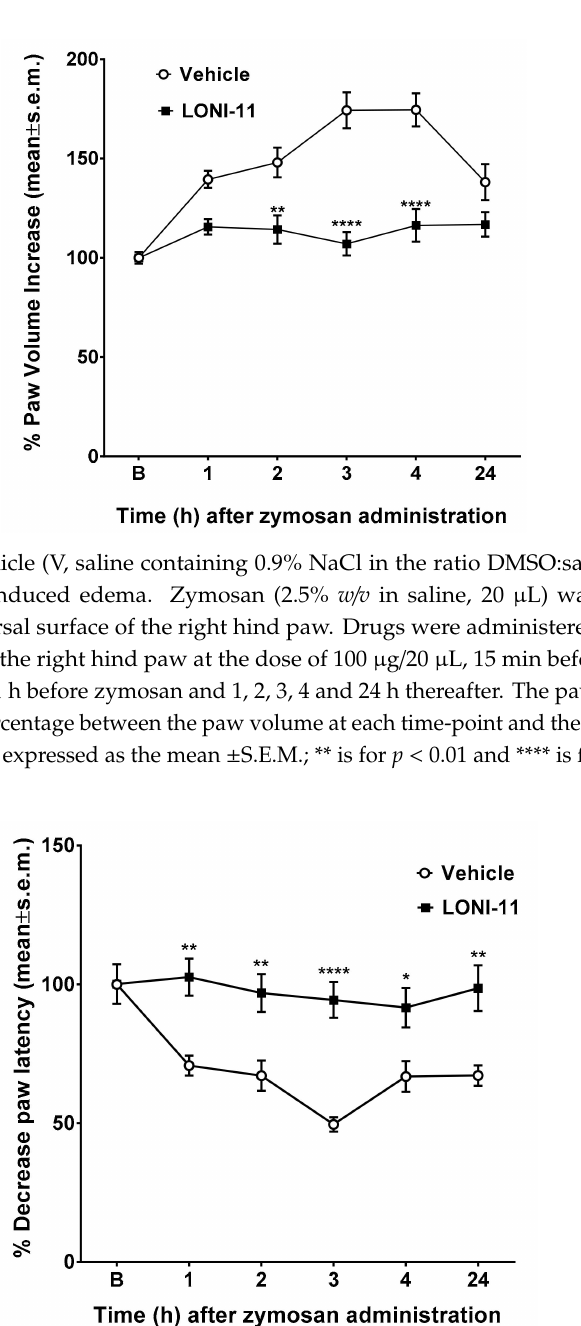
Figure 7. E ff ects of vehicle (V, saline containing 0.9% NaCl in the ratio DMSO:saline 1:3 ( v / v )), and LONI11 on zymosan-induced paw hyperalgesia. Zymosan (2.5% w / v in saline, 20 µ L) was subcutaneously administered in the dorsal surface of the right hind paw. Drugs were administered subcutaneously in the dorsal surface of the right hind paw at the dose of 100 µ g / 20 µ L, 15 min before zymosan. Paw latency was measured 1 h before zymosan and 1, 2, 3, 4 and 24 h thereafter. The paw latency decrease was evaluated as the percentage between the paw latency at each time-point and the basal paw latency. The results obtained are expressed as the mean ± S.E.M.; * is for p < 0.05, ** is for p < 0.01 and **** is for p < 0.0001 vs. V. N =